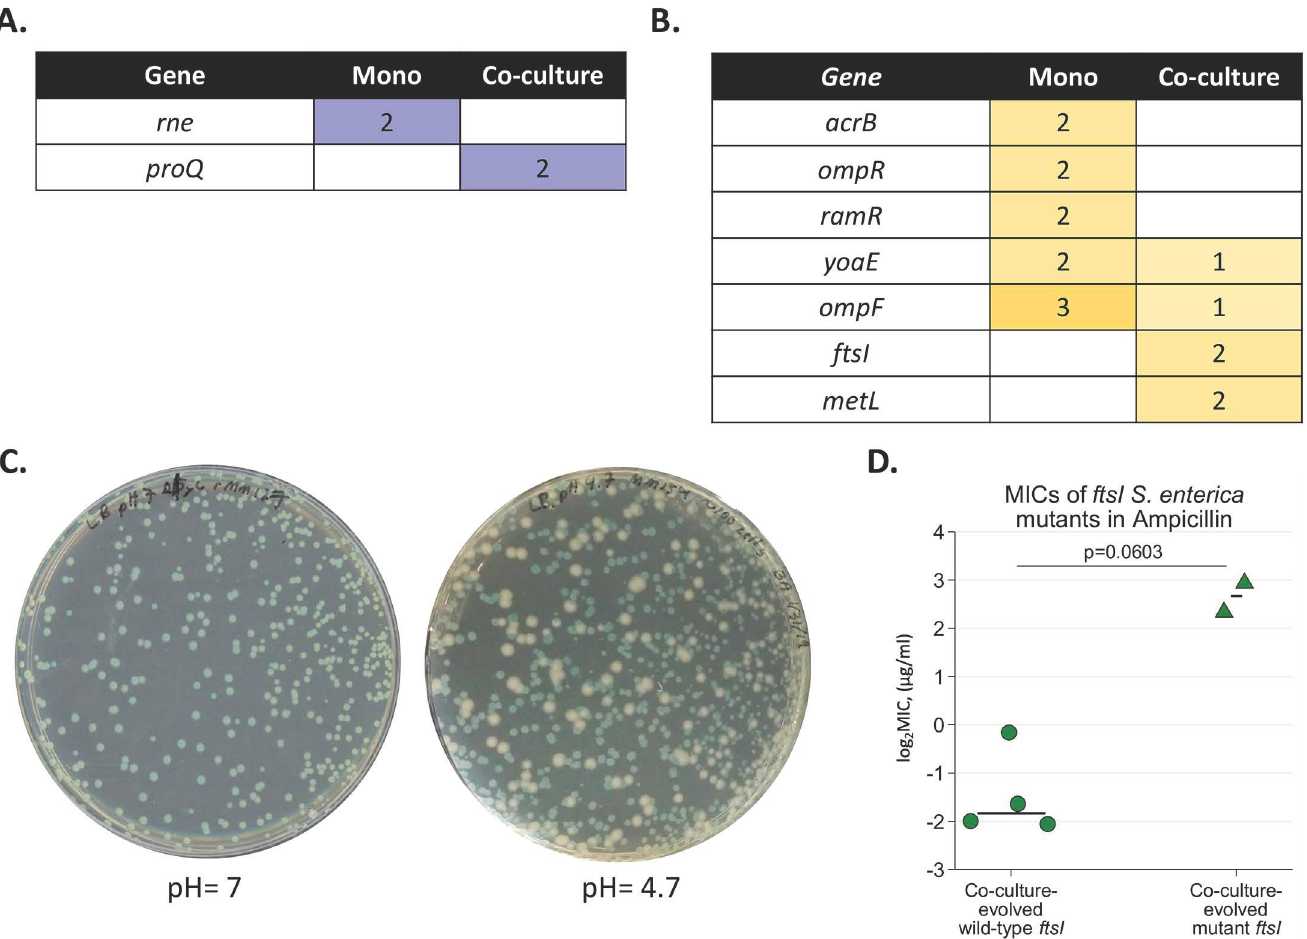
Fig 4. Resistance- associated mutations in ampicillin-resistant evolved populations A-B. Lists of mutations which arose in E . coli ( A ) or S . enterica ( B ) monocultures and co-cultures. The number in each box represents the number of independent replicates in which the putative resistance mutation was observed. Additional mutations that occurred in only one population, and details on the nature of these mutations, may be found in S1 Table . C. Image of co-culture populations containing ftsI mutations on Petri plates with LB pH = 7 (left) and pH = 4.7 (right). Blue colonies are E . coli which metabolize X-gal to a blue color; white colonies are S . enterica . No white colonies were observed on LB at pH = 7. D. MICs of isolates from libraries containing ftsI mutations in pH = 4.7 medium. Isolates were obtained from passage 10 populations by streaking onto selective medium and picking isolated colonies. Each data point represents the average MIC of three isolates from a single population. For each species- culture type combination, there are six populations total, and the statistical comparisons represent MIC comparisons between populations with wild type vs. mutant alleles MIC 90 values for isolates were defined as the lowest concentration of antibiotic which decreased growth by greater than 90% by 48 hours at 30˚C. Each point represents the average MIC of three isolates from a single population. P = 0.0603, Mann-Whitney U.